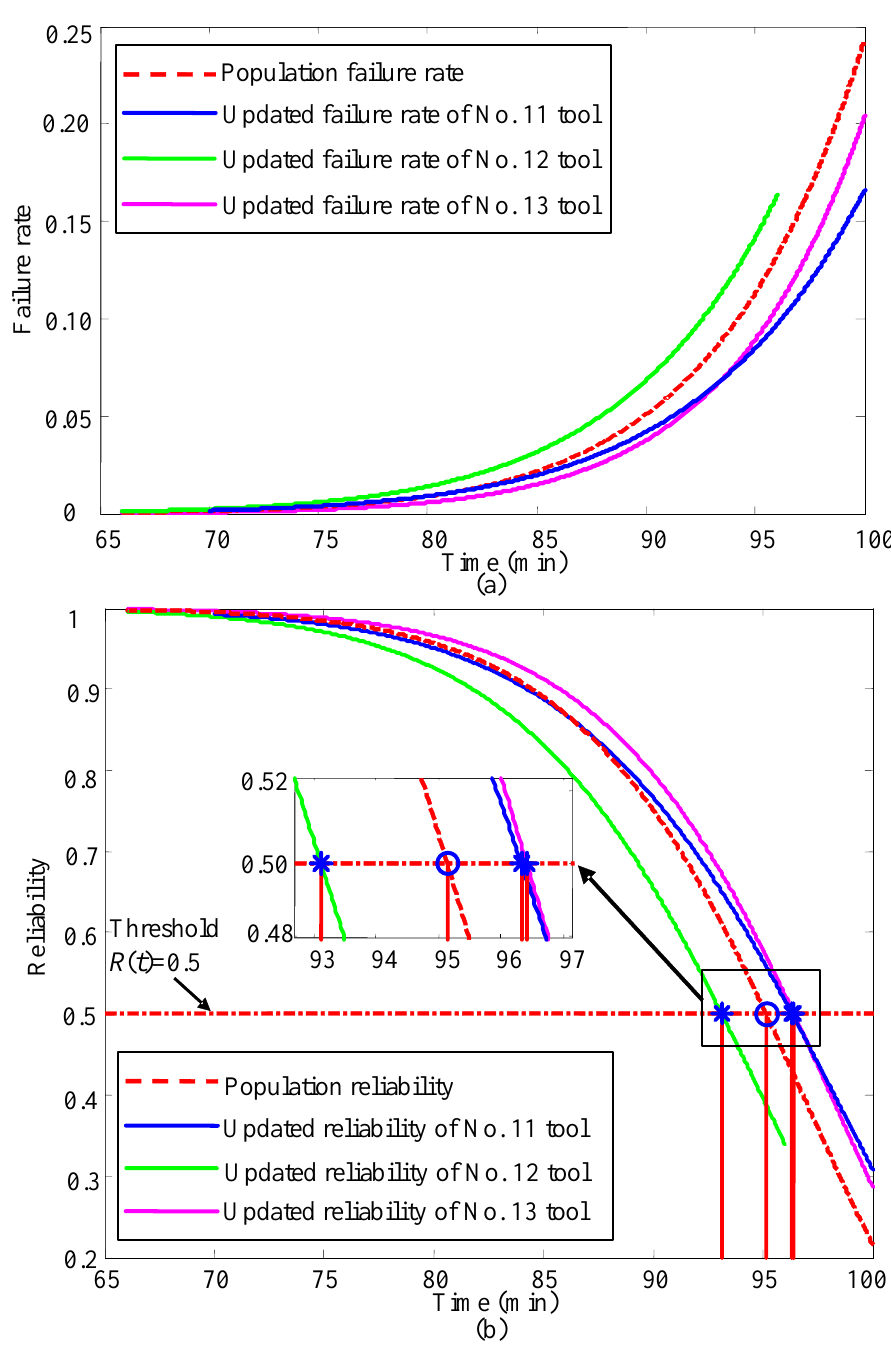
Figure 9. ( a ) Failure rate comparison. ( b ) Reliability